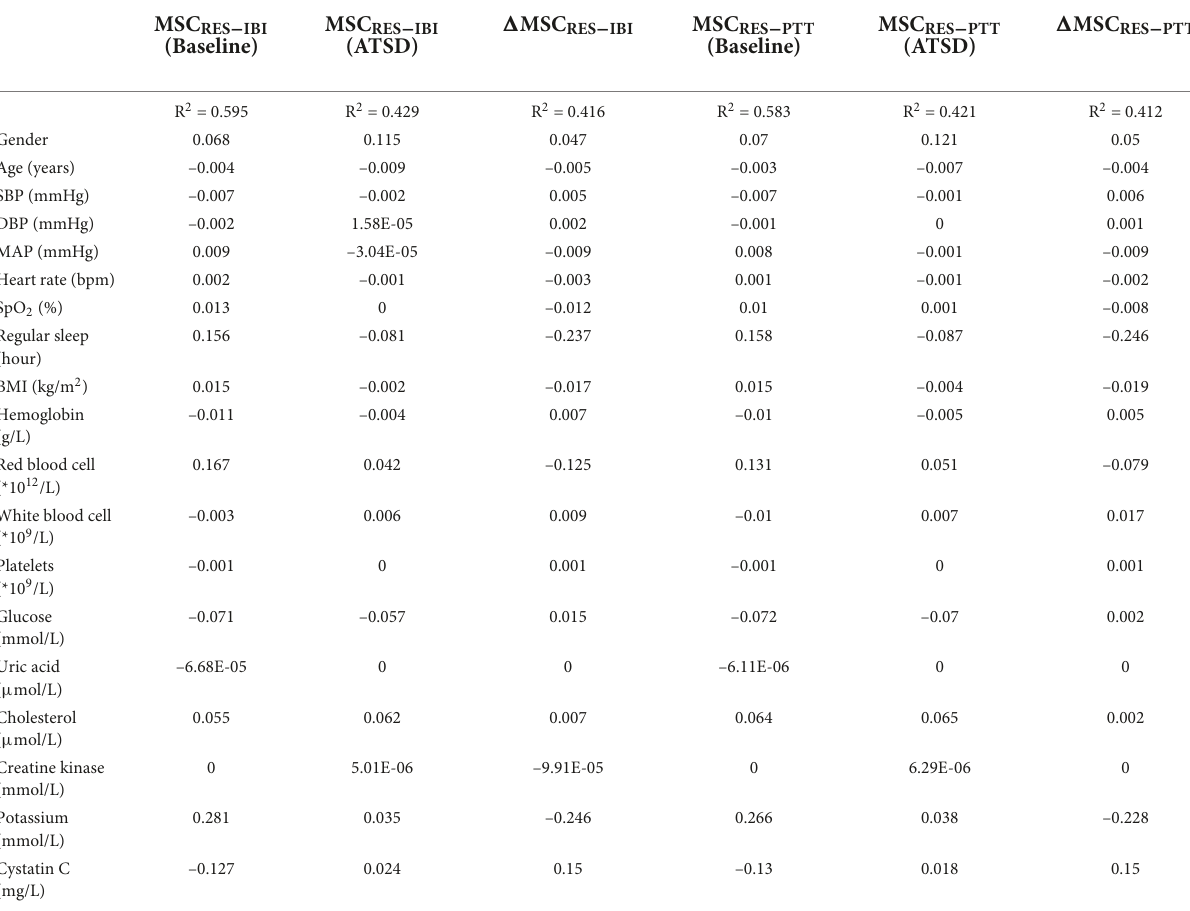
TABLE 4 Multiple linear regression models predicting significantly changed physiological coupling